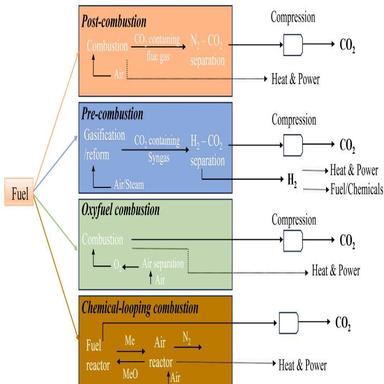
Shows the schematic representation of oxyfuel.